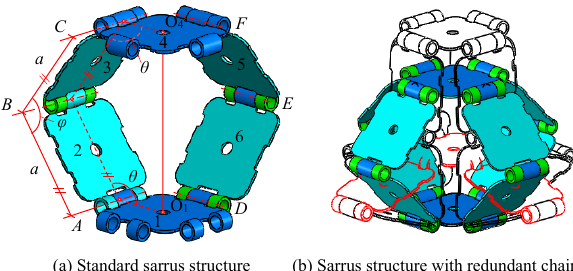
Figure 3. Bio-inspired Sarrus-linkage-based mechanical muscle.